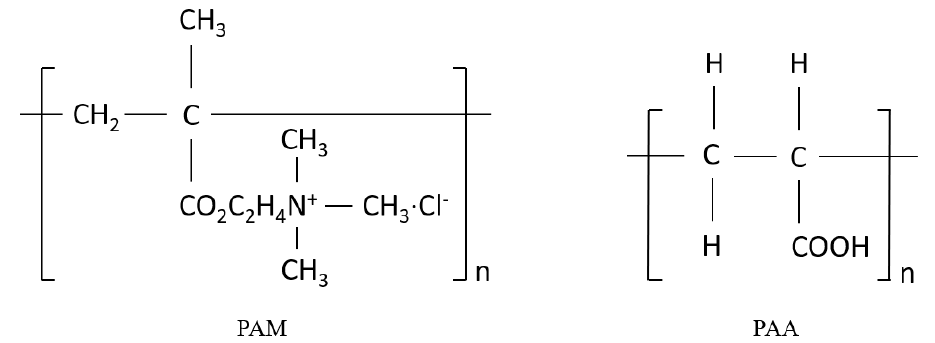
Figure 1. Chemical structures of monomer unit of poly ((2-dimethylamino)ethyl methacrylate) methyl chloride quaternary salt (PAM) and polyacrylic acid (PAA). Molecular weights of monomer unit for PAM and PAA are 207.5 and 71 g/mol, respectively.